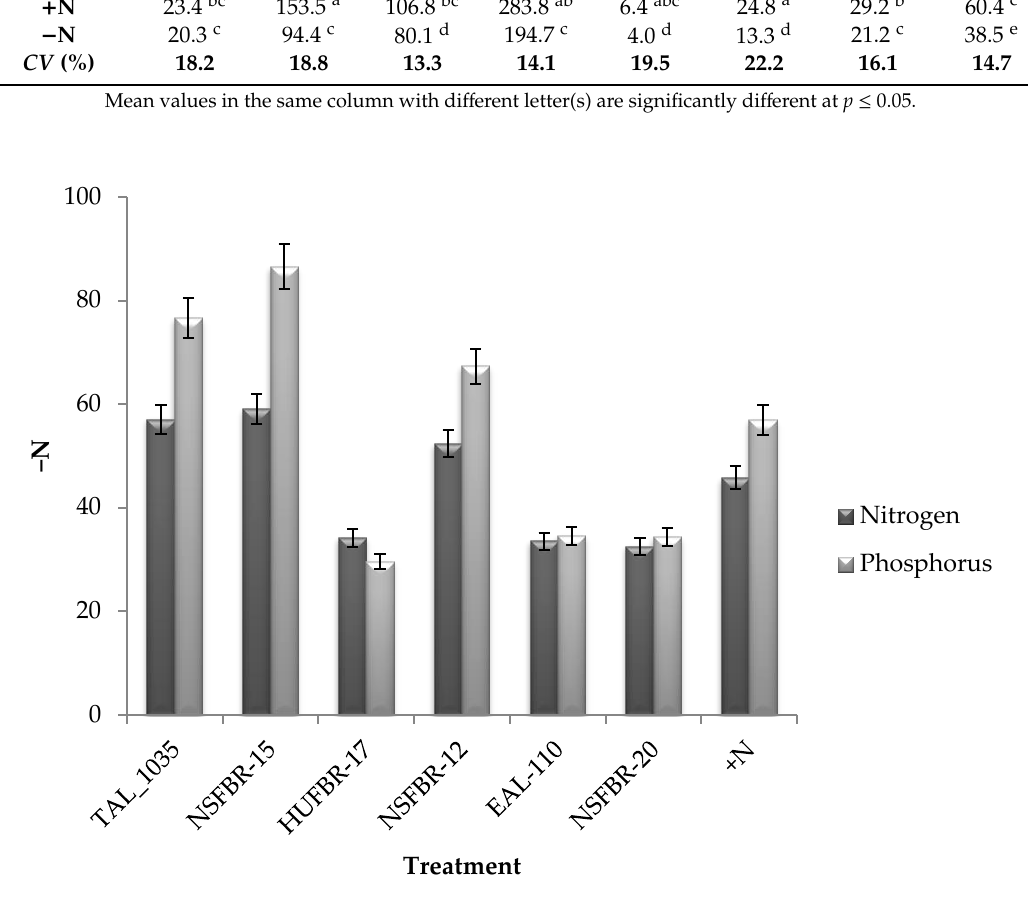
Figure 1. Percentage increase in total nitrogen and phosphorus uptake in inoculated plants over non-inoculated −N control.